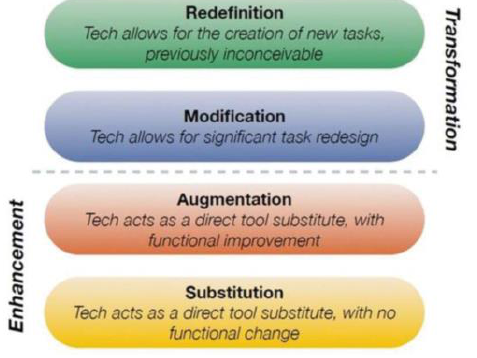
Figure 1. SAMR model. ( Puentedura